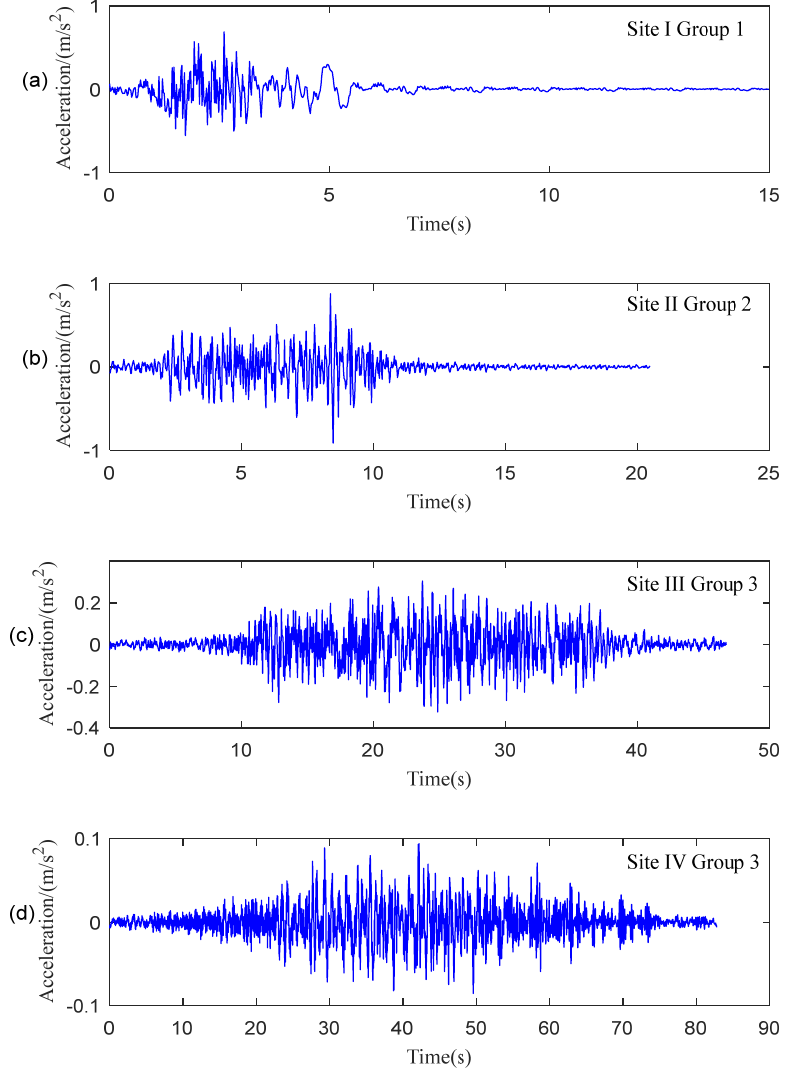
Figure 2. Typical simulated seismic ground motions. ( a ) Site I Group 1; ( b ) Site II Group 2; ( c ) Site III, Group 3; ( d ) Site IV Group 3.